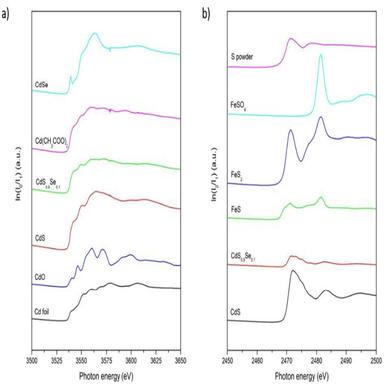
(a) The L-edges absorption of Cd and (b) K-edges absorption S element of CSS_An_500_5 sample with standard chemicals collected by XAS technique.